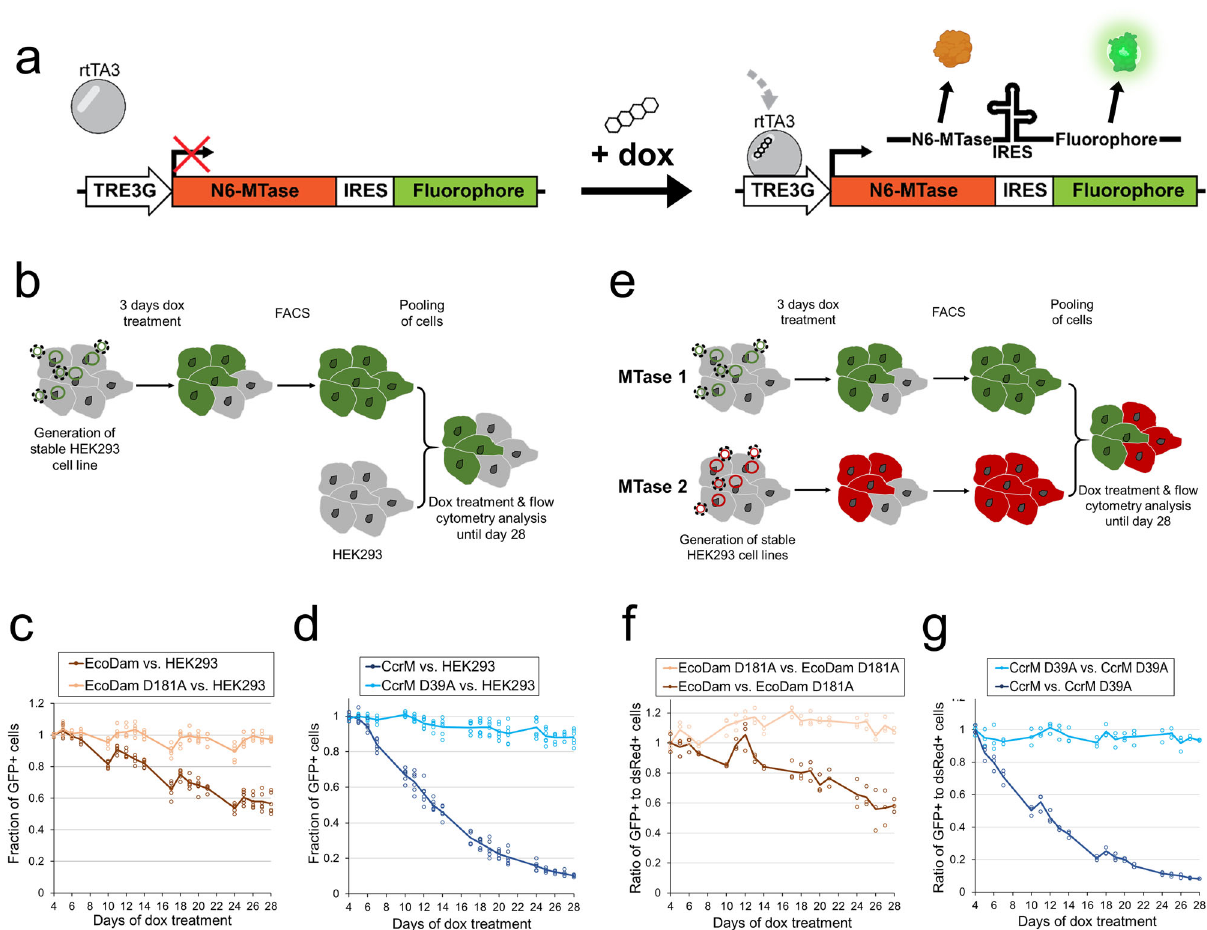
Fig. 1 Cell viability effects of the genome-wide deposition of m6dA by expression of bacterial N6-MTases. a Design of the N6-MTase expression constructs which were stably integrated into the genome of HEK293 cells. The reverse tetracycline-controlled transactivator 3 (rtTA3) binds the TRE3G promoter in the presence of dox, thus activating the expression of the N6-MTase. A fl uorophore is co-expressed over an internal ribosomal entry site (IRES). b Schematic depiction of the experimental work fl ow used for the competitive proliferation assay of N6-MTase versus HEK293 cells. c , d Flow cytometry results of the competitive proliferation assay for EcoDam (WT and D181A mutant), or CcrM (WT and D39A mutant), against HEK293 cells. The fraction of GFP-positive (GFP + ) cells relative to non- fl uorescent cells was calculated and normalized to day 4 of dox treatment. e Schematic depiction of the experimental work fl ow used for the competitive proliferation assay of N6-MTase 1 (GFP + ) versus N6-MTase 2 (dsRed + ). f , g Flow cytometry results of the competitive proliferation assay for EcoDam or CcrM variants (GFP + ) versus the corresponding inactive mutants (dsRed + ). The fraction of GFP + cells was calculated and normalized to day 4 of dox